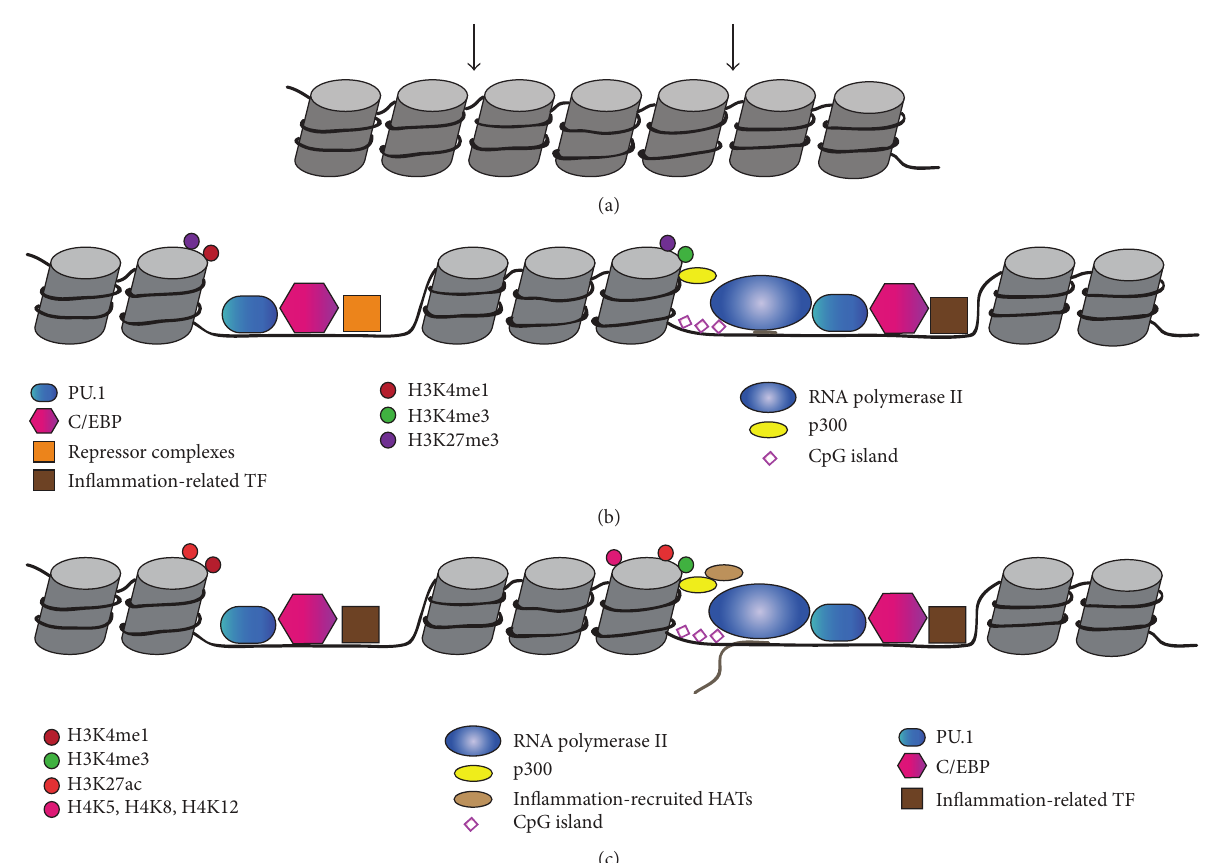
Figure 1: Epigenetic regulation in macrophages in homeostasis and inflammation. (a) During lineage establishment, the master macrophage regulator PU.1 unpacks the tight organisation of chromatin and binds to its motifs on the DNA sequence (arrows). Additional macrophage- restricted TFs interact with PU.1 and are subsequently recruited to the loosened DNA resulting in establishment of nucleosome-free regions at macrophage enhancers and promoters. (b) Enhancers are epigenetically marked by the H3K4me1 signature, whereas promoters are H3K4me3 labelled. Genes which are not active at baseline may be poised, meaning that their enhancers are marked by H3K27me3 signatures, rendering them ready to promote gene transcription in the presence of an appropriate stimulus. One category of such genes is the primary response genes, which exhibit active repression at their enhancers and are transcribed at low levels. (c) In the presence of local signals, these genes lose the suppressive H3K27me3 mark on their enhancers and promoters and are acetylated at H3K27 by the constitutively present p300 and recruited acetyltransferases. The produced transcripts are successfully elongated and leave the nucleus for protein synthesis. This conversion is facilitated by inflammation-related TF, which bring enhancers close to gene promoters to initiate gene transcription.